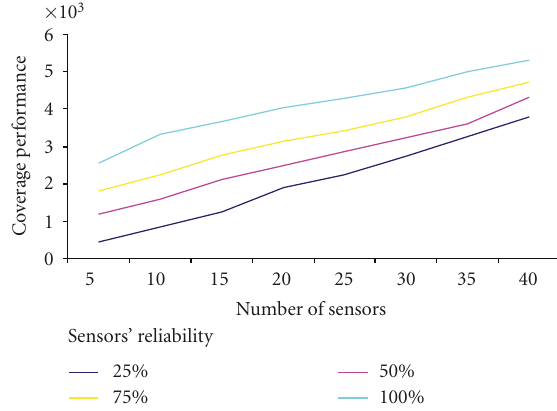
Figure 16: E ff ect of sensors’ mobility on the coverage performance of GA and SA.